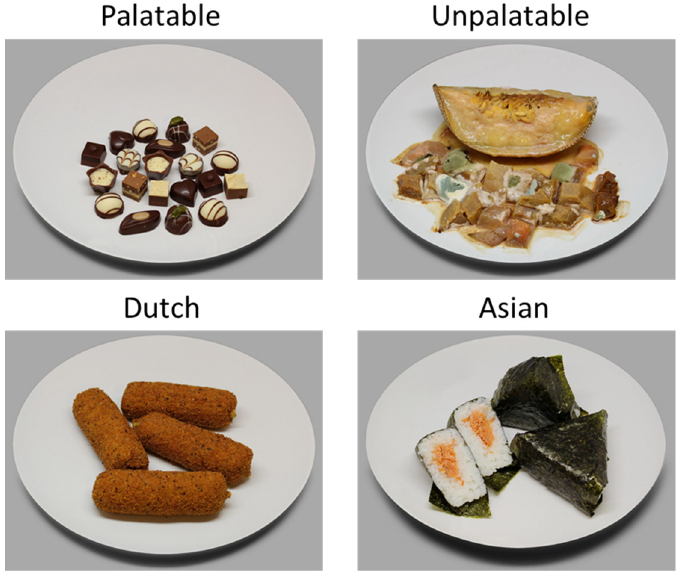
Figure 1. Example image from each of the four food image categories. Each category was represented by 20 unique images.